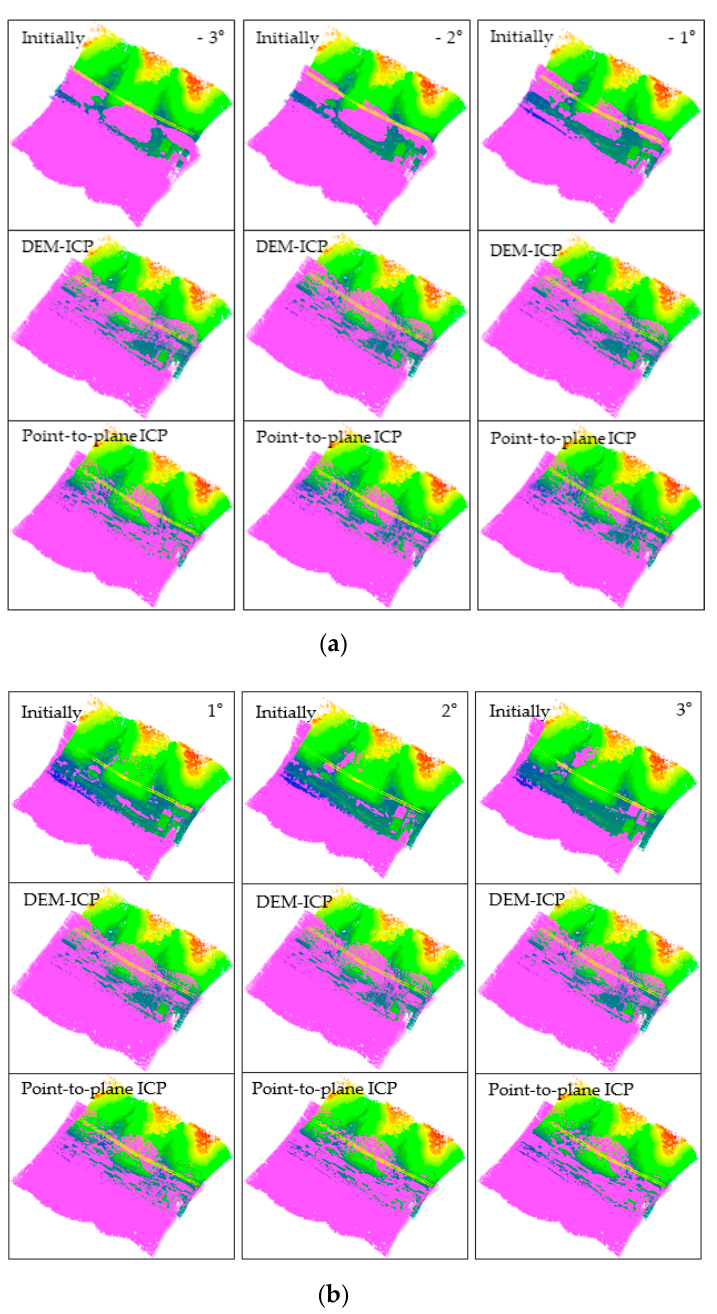
Figure 10. Registration results of the performance comparison experiment. The colored point cloud displayed by elevation is Strip 3, and the purple point cloud is Strip 6: ( a ) the rotation angle θ range from − 3° to − 1°; ( b ) the rotation angle θ range from 1° to 3°.